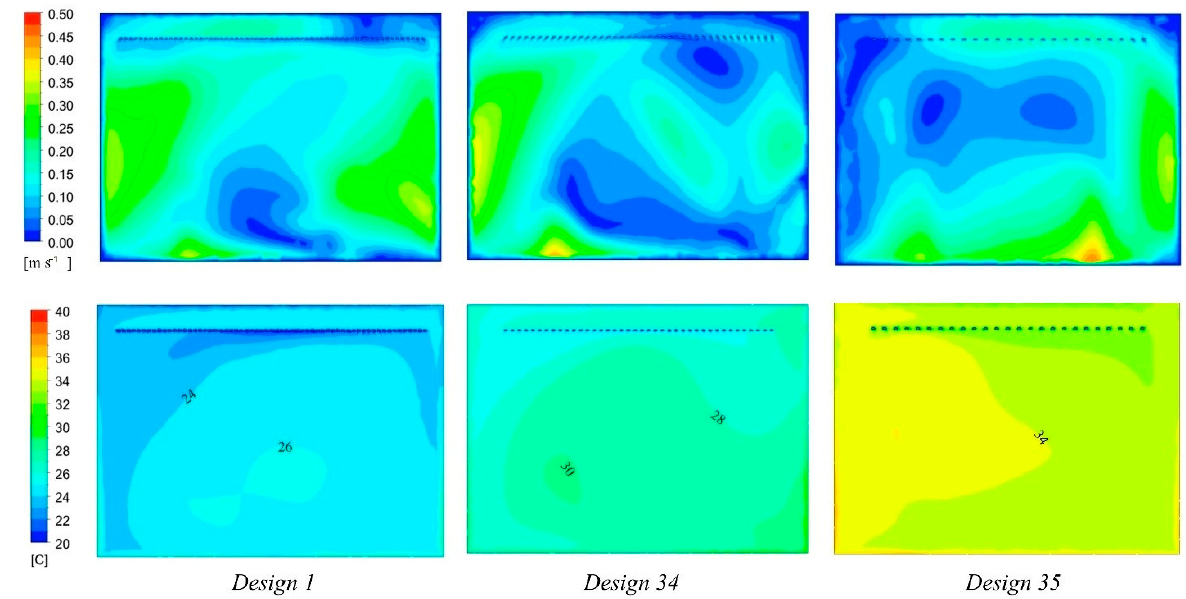
Figure 15. k and n of different CRCP designs ( T op − T s = 8 K) [27,32].